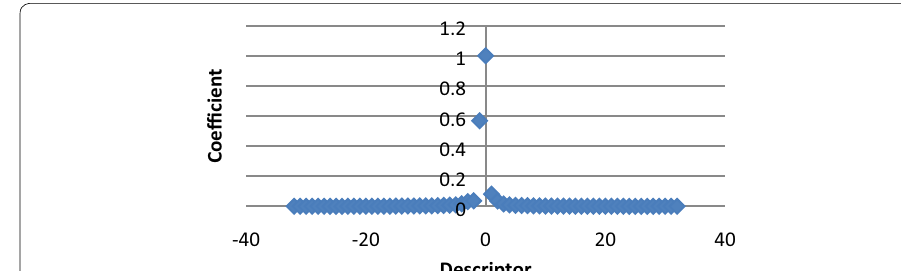
Fig. 10 Descriptor magnitude for Dissa calcareous sand